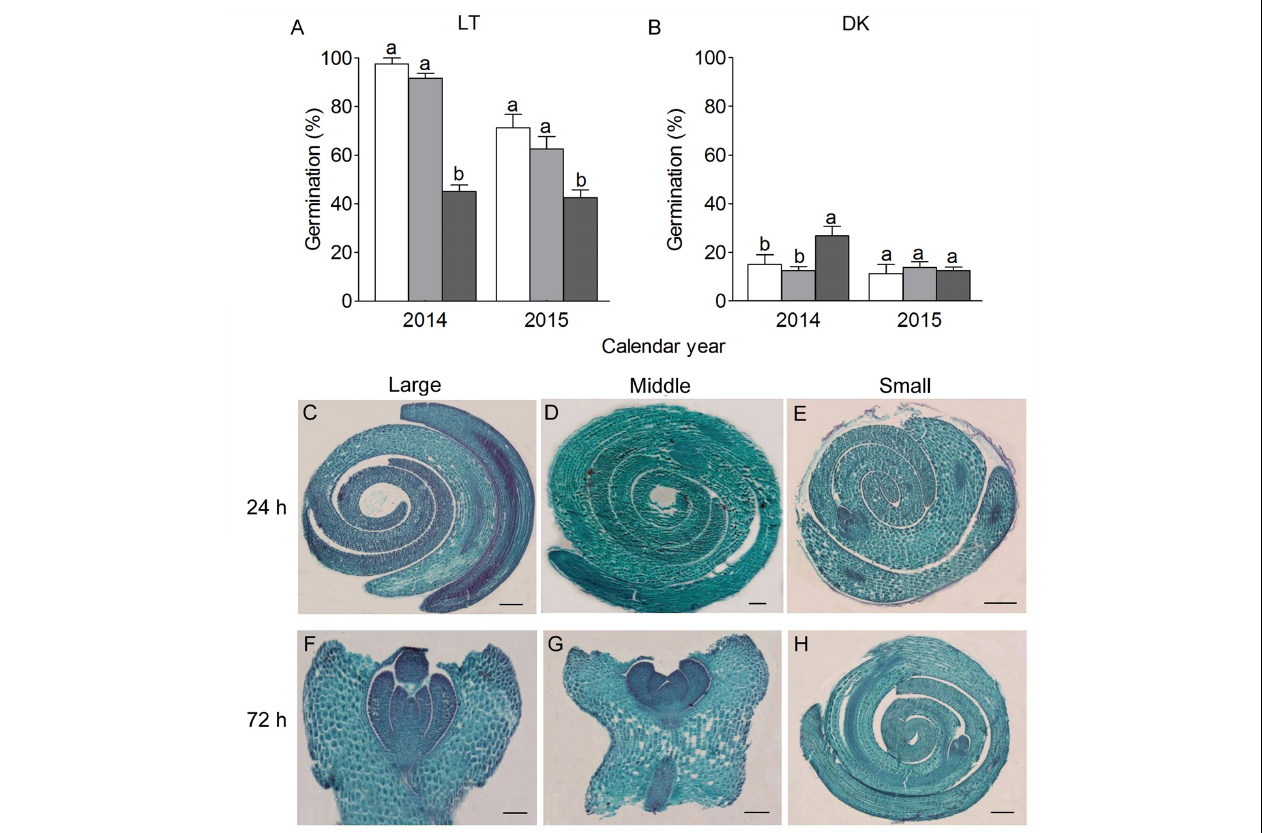
FIGURE 3 | Seed germination and the morphological changes of heteromorphic seed of S. ferganica. (A,B) Germination percentage of heteromorphic seeds in light or dark in February of the next year of 2014 and 2015, respectively. Bars with different lowercase letters indicate significant differences ( P < 0.05) according to the Tukey’s test. Values are means ± SE of four replicates in (A,B) . (C–H) Longitudinal cross section of seed; (C,F) large seed; (D,G) middle seed; (E,H) small seed. (C–E) Germination for 24 h. (F–H) germination for 72 h. Scale bars: (C–E) 200 µ m, (F–H) 100 µ m.